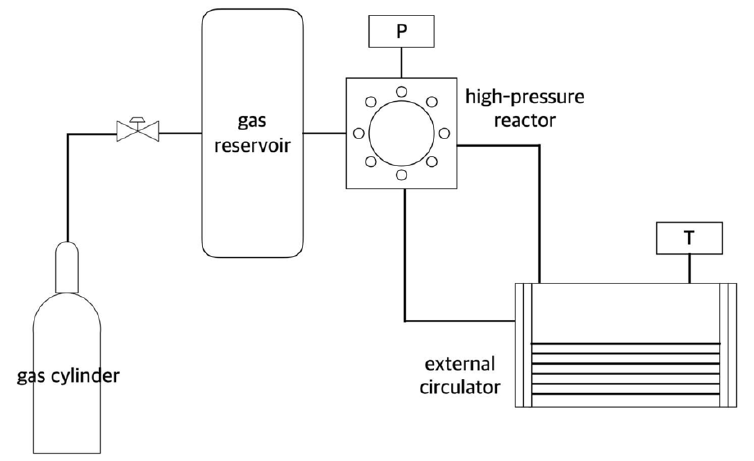
Figure 1. A schematic diagram of the experimental instrument.